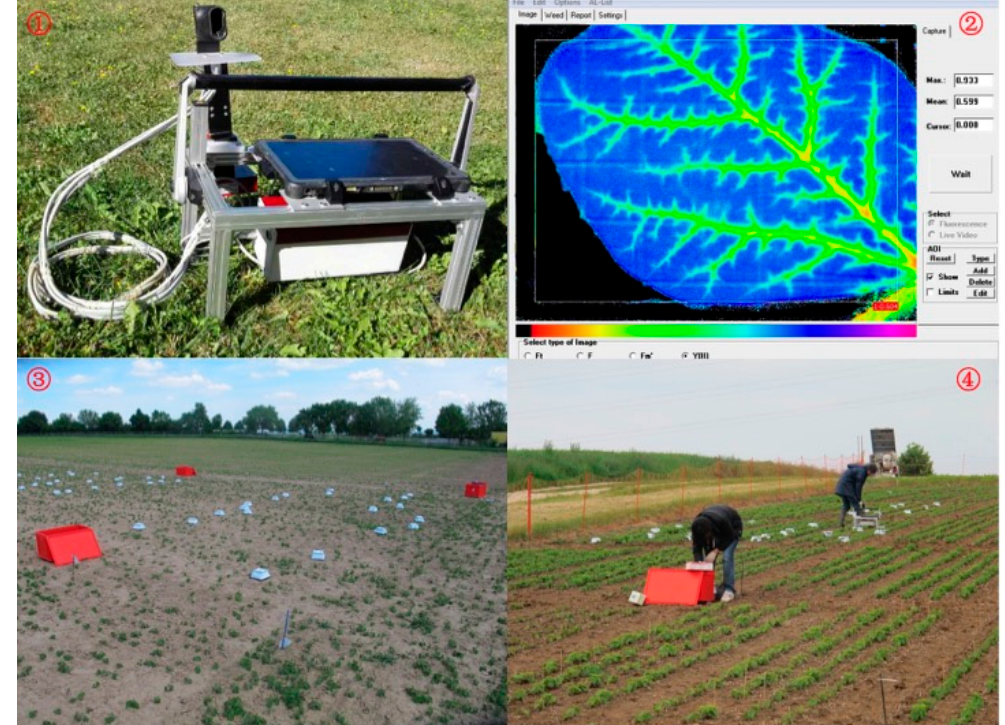
Figure 1. The field chlorophyll fluorescnce sensor WEED-PAM ® . ① A picture of the sensor. It consists of the camera control unit and the computer including software; ② The software interface when measuring a herbicide treated leaf of soybean. The purple and blue pixels represent leaf area with higher Fv/Fm values, while the red pixels represent leaf area with lower Fv/Fm values. Blue color represents high Fv/Fm values and healthy tissues while the yellow and red color represents pixels with low Fv/Fm values and plant damage; ③ Dark adaption cover box distribution when conducting the first measurement at the one-leaf stage of soybeans at site Böblingen; ④ Measurement at the two-leaf stage of the soybeans at site Nürtingen.